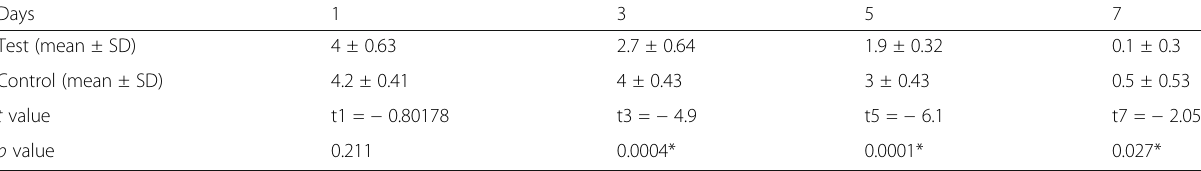
Table 1 Visual analogue scale scores (VAS) for laser and control groups during the study period Days 1 3 Test (mean ±